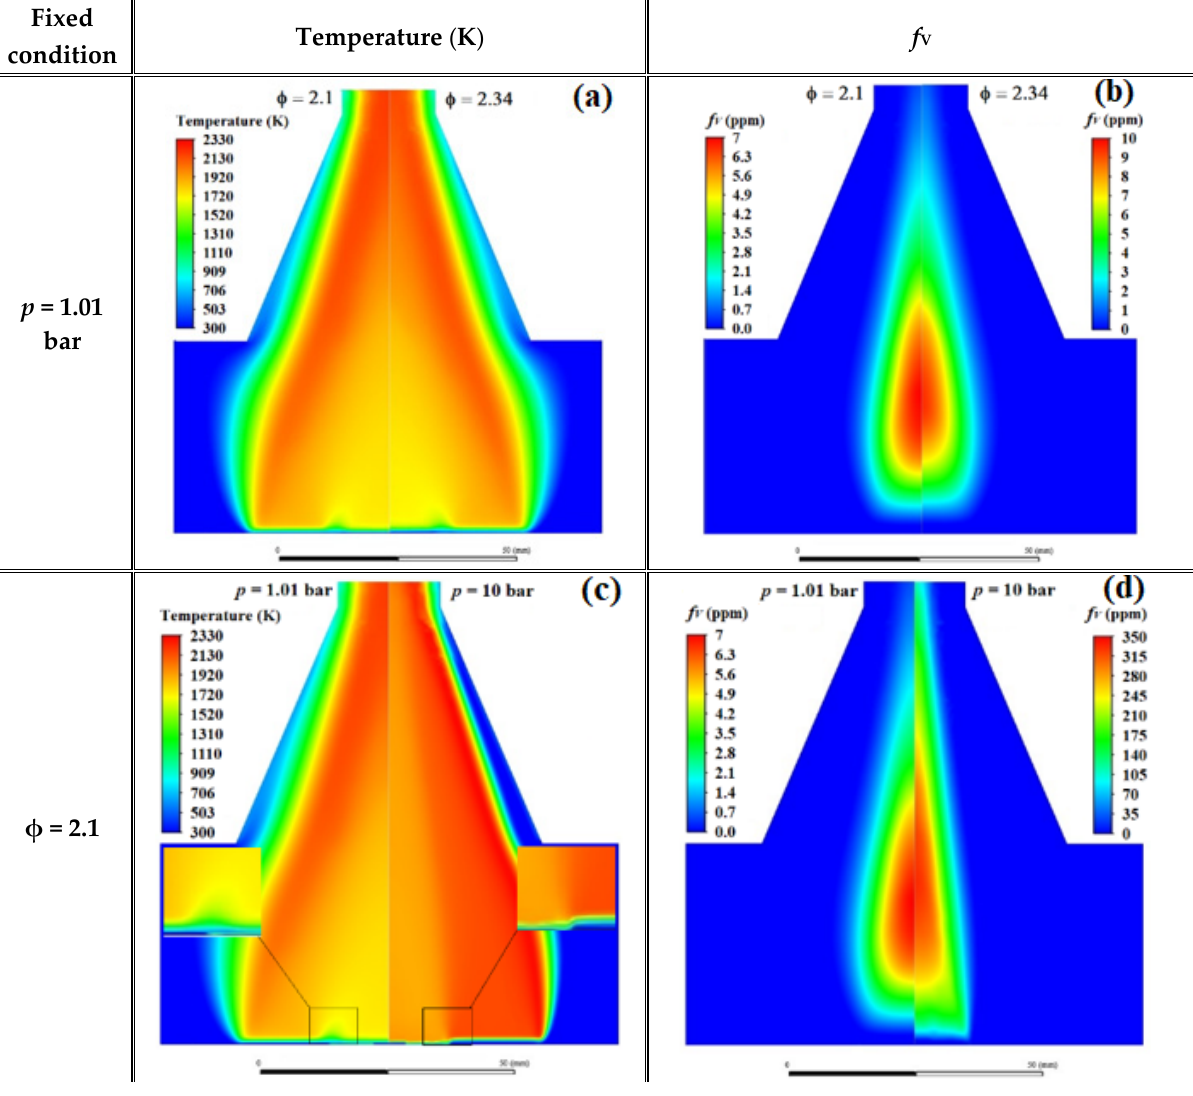
Figure 11. Temperature (K) and f V (ppm) cross-sectional distributions of premixed flames C 2 H 4 /air ϕ = 2.1 and 2.34 of matrix diameter 20 mm shielded by a non-sooting flame of CH 4 /air ϕ = 1.2 at p = 1.01 and 10 bar.